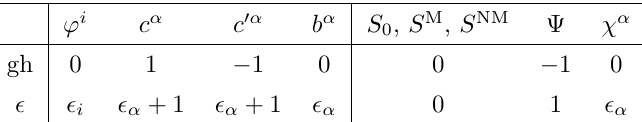
) = − gh(Φ I ) − 1 and the opposite parity, I